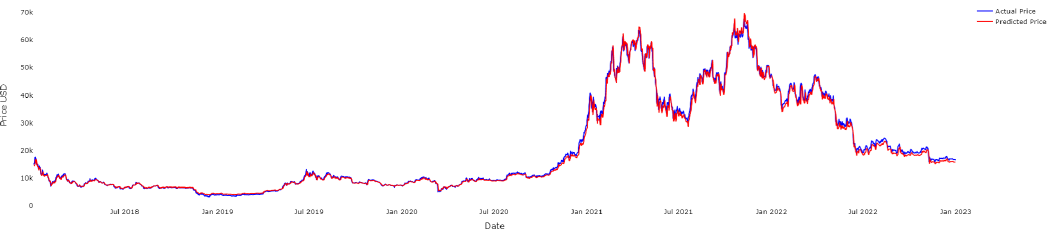
Figure 12. BTC—actual and predicted results using the LSTM model.